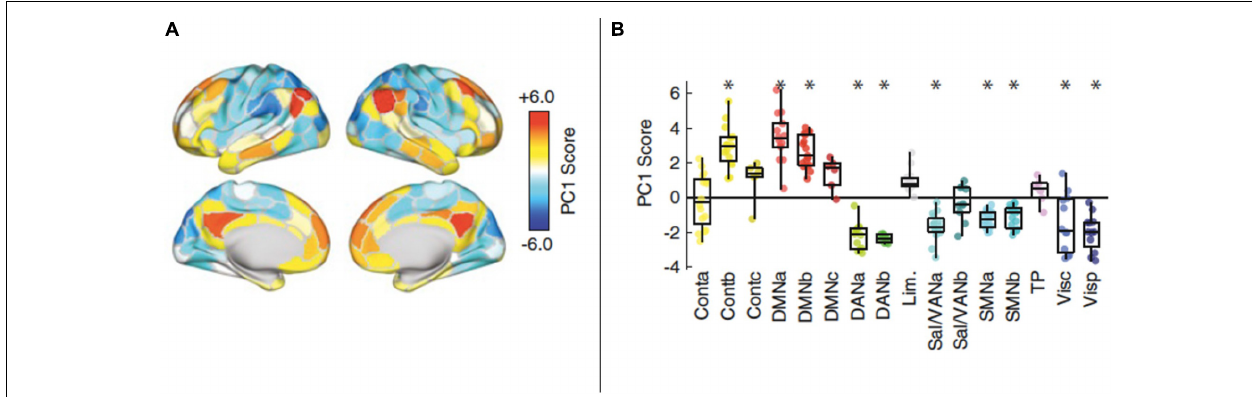
FIGURE 10 | (A,B) Networks identified as contributing to the high-amplitude co-fluctuations. Positive contributions were indicated by high PC1 scores, with significant contributions made by default mode areas (within DMNa and DMNb) or control areas (within Contb). On the right, asterisks correspond to PC1 scores obtained in a principal component analysis (performed on a correlation matrix not shown in this modified figure). Further details describing the principal component analysis used to obtain these results can be found in Esfahlani et al., 2020. Reprinted with permission from Esfahlani et al.